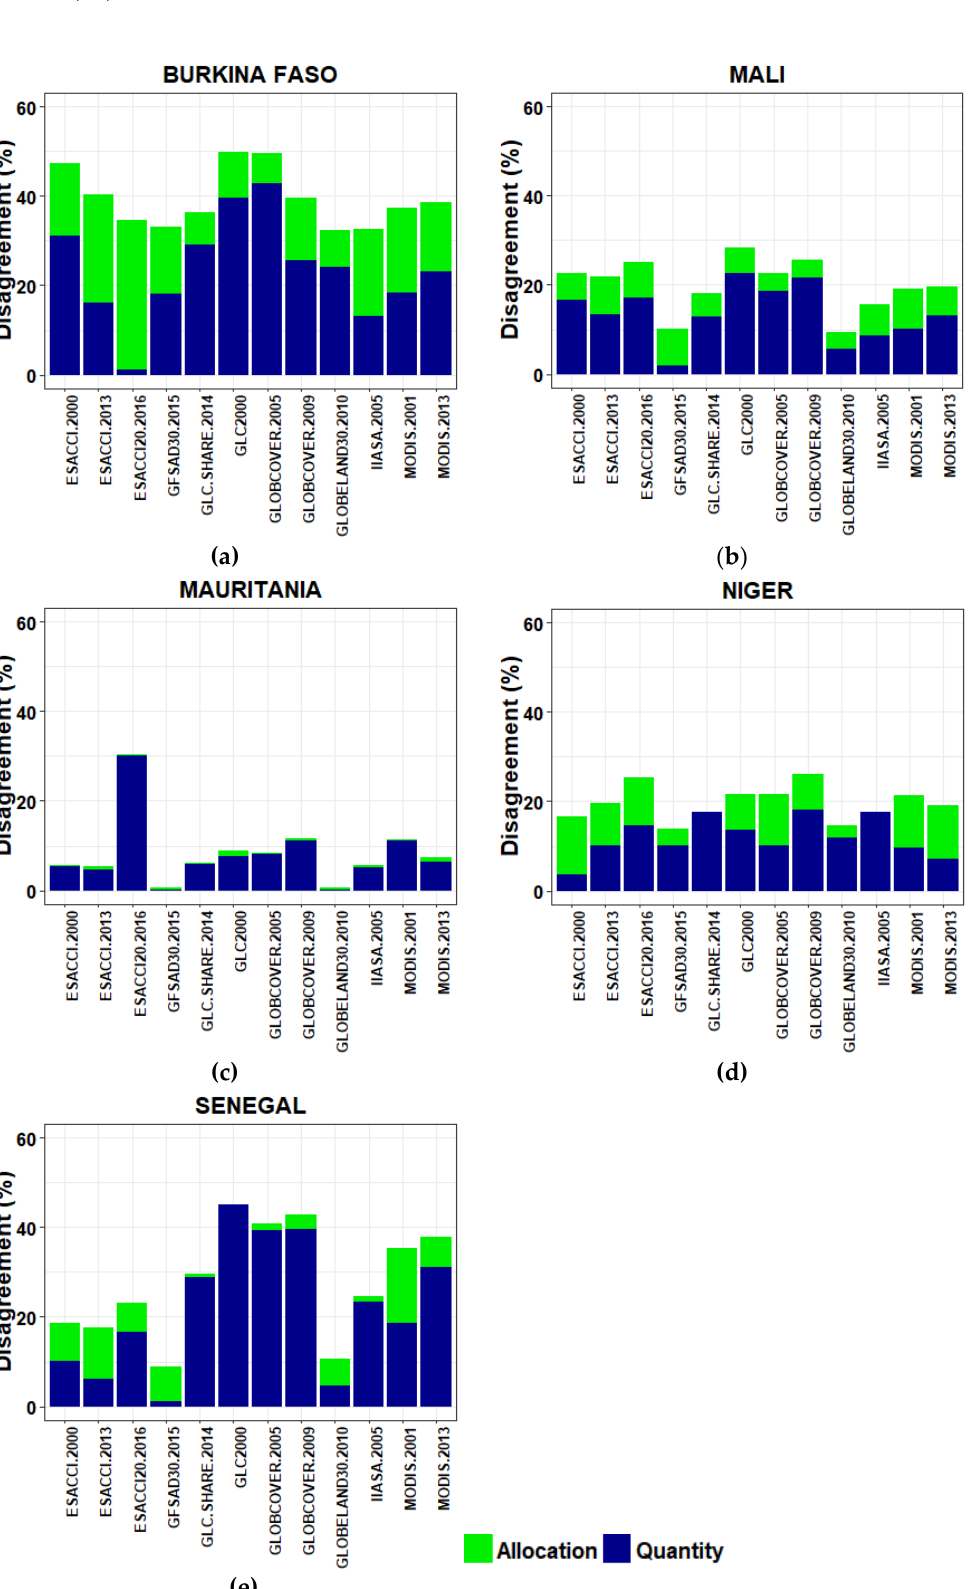
Figure 3. All cropland (sum of crop and mixed-crop classes) quantity disagreement (quantity = how much cropland) and allocation disagreement (allocation = where the cropland is) in five Sahelian West African countries: Burkina Faso ( a ), Mali ( b ), Mauritania ( c ), Niger ( d ) and Senegal ( e ). Twelve independent land cover assessments (eight “products”, some with multiple years) are used.